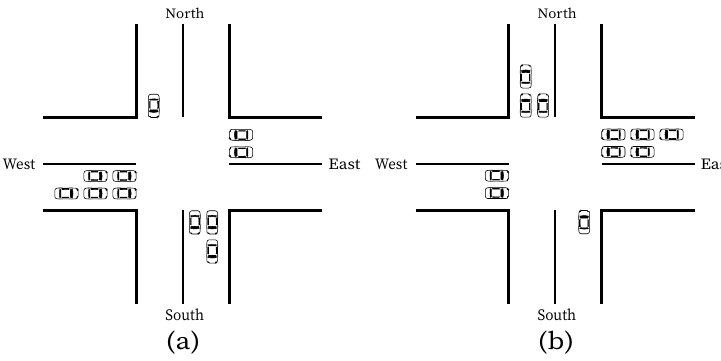
Figure 2. Traffic state with symmetry. ( a , b ) are similar traffic scenarios.